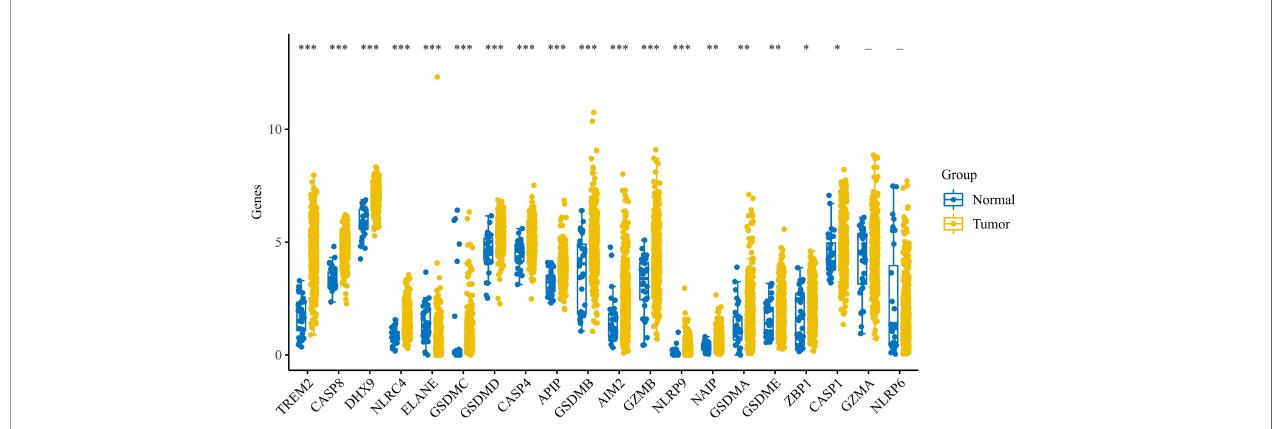
FIGURE 1 | Expression of pyroptosis-related genes in gastric cancer. Expression of pyroptosis-related genes in gastric cancer. * indicates p < 0.05 for comparison between gastric cancer and paraneoplasia; ** indicates p < 0.01 for comparison between gastric cancer and paraneoplasia; *** indicates p < 0.001 for comparison between gastric cancer and